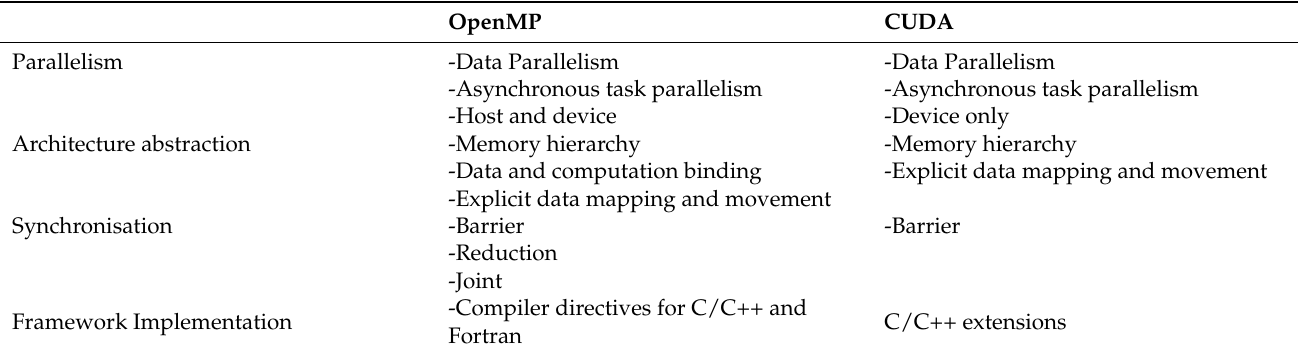
Table 1. Major features of OpenMP and CUDA